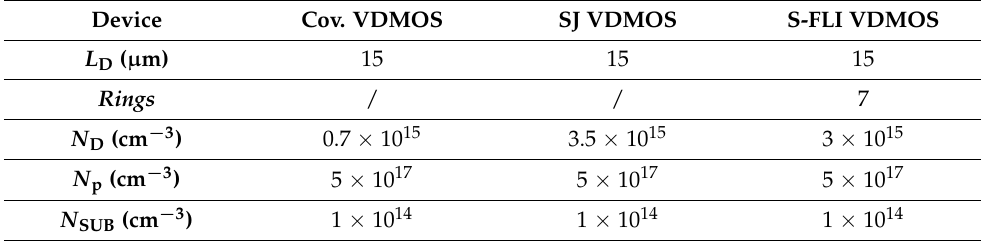
Figure 2. Distributions of the leakage current, ( a ) Cov.VDMOS, ( b ) S-FLI VDMOS. The environment temperature is 300 K. BV is obtained at V GS = 0 V, and R on,sp is obtained at V GS = 10 V. The physics models applied in the ISE simulation mainly includes Mobility (DopingDep High Field Sat Enormal), EffectiveIntrinsic Density (OldSlotboom), Recombination (SRH (DopingDep) and Auger Avalanche (Eparal)). The criterion of break- down is BreakCriteria {Current (Contact = “drain” Absval = 1e − 7)}. The breakdown condition is defined as the point at which the ionization integral equals unity. It is necessary to optimize the parameters in the numerical simulations. Some device parameters in the simulation are listed in Table 1. The simulation results based on the parameters in Table 1 are shown in Table 2. Table 1. Device parameters in the simulation.